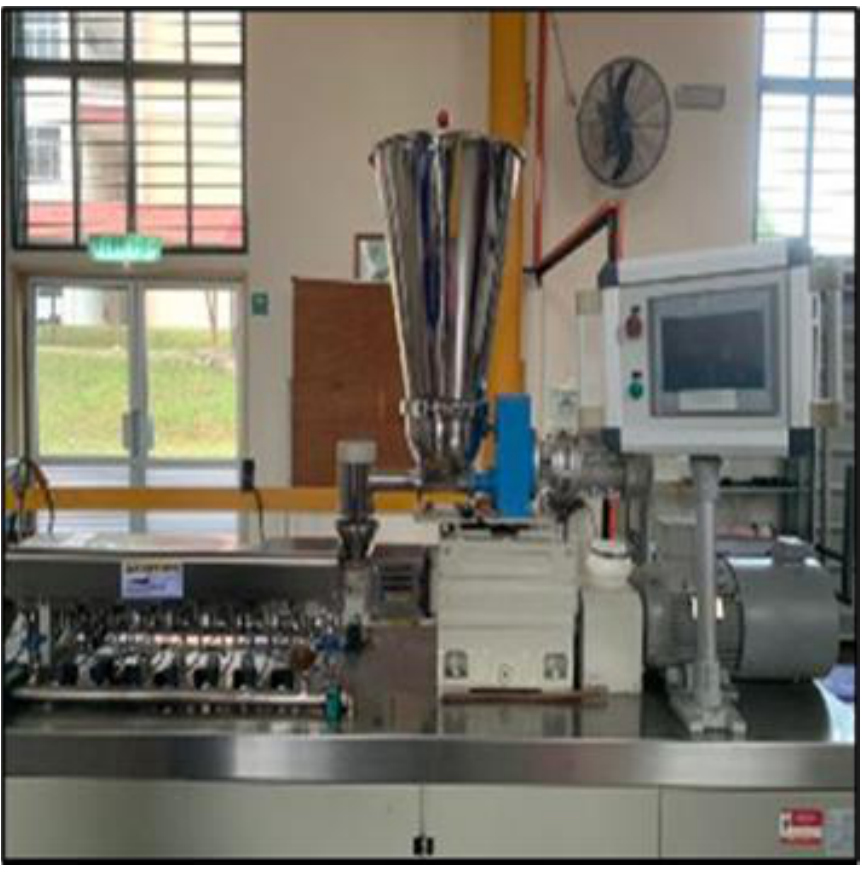
Figure 1. Twin screw extruder. Table 4. Parameter of extrusion.